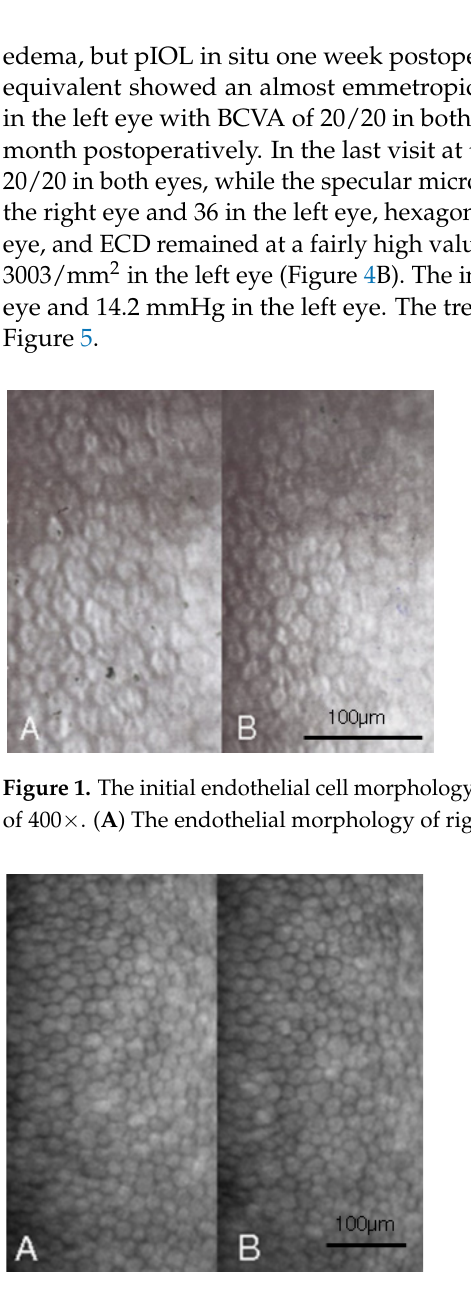
Figure 4. The endothelial cell morphology three months postoperatively with nominal magnifica- tion of 400×. ( A ) The endothelial morphology of right eye. ( B ) The endothelial morphology of left eye. Figure 5. The bar chart of the endothelial cell density change throughout the study period. 3. Discussion The application of AA to manage various diseases originates from the fact that it has anti-oxidative ability and it is an ideal ocular nutritional supplement [13,14]. In systemic diseases, intravenous AA has proven as an effective and safety management agent in the retardation of severe sepsis and the extent of multiple organ failure [15]. In addition, AA can also be applied to patients with cancer to reduce the symptoms including fatigue, pain and mood disorders to improve the quality of life [16]. Concerning ophthalmic disorders,